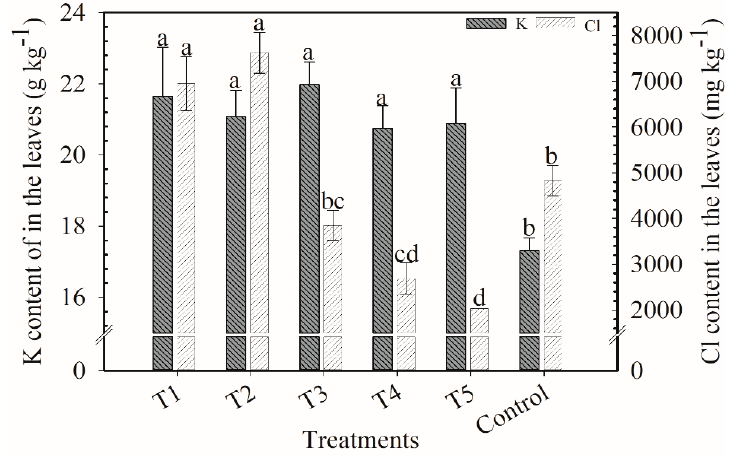
Figure 2. K and Cl contents in the leaves of coffee plants, 20 days after application of the second cover fertilization parcel. Harvest of 2018/2019. Means followed by the same letter in the column do not differ according to Tukey’s test ( p < 0.05). Vertical bars indicate the standard error of the mean ( n = 4). T1: 100% KCl; T2: 75% KCl + 25% K 2 SO 4 ; T3: 50% KCl + 50% K 2 SO 4 ; T4: 25% KCl + 75% K 2 SO 4 ; T5: 100% K 2 SO 4 ; control did not receive K 2 O.